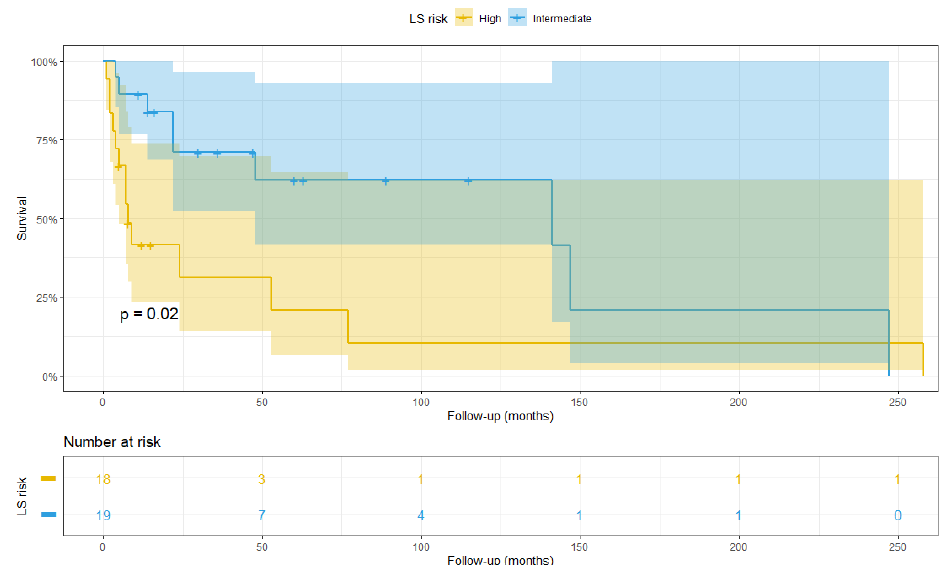
Figure 12. Patients belonging to the whole slide cohort stratified at high (yellow) and intermediate (blue) risk according to the ISUP